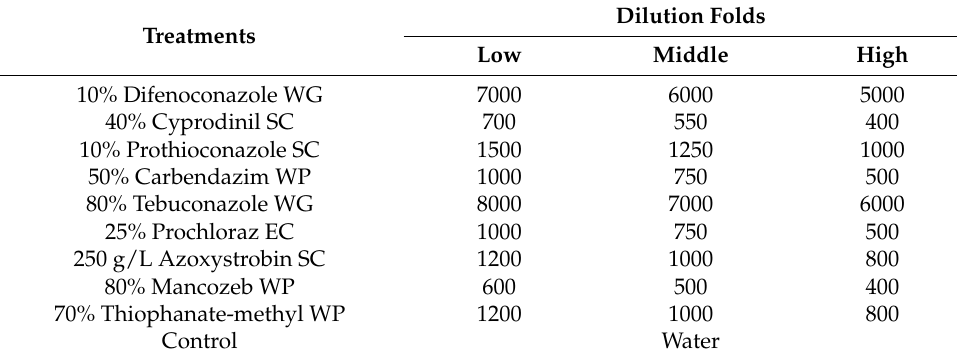
Table 3. The experimental treatments of the tested